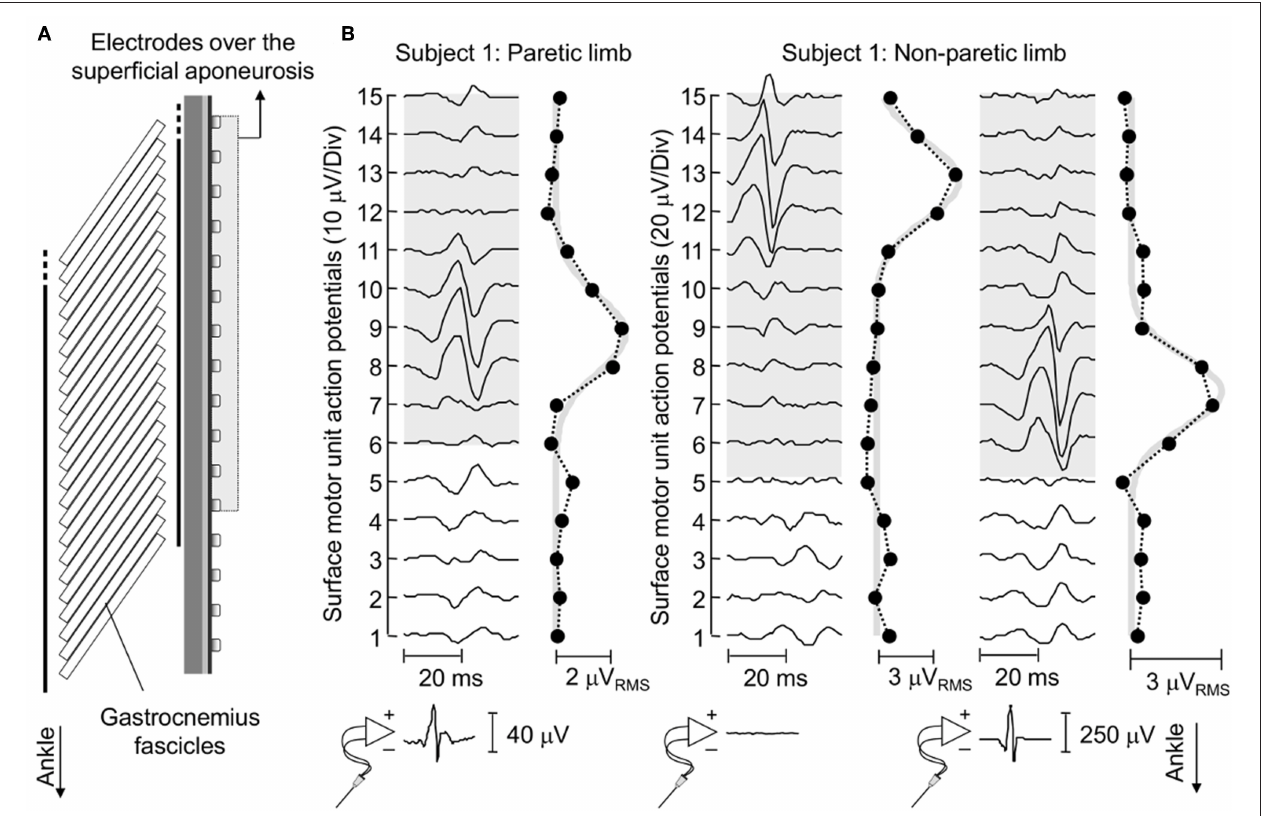
FIGURE 4 | Surface representation of motor unit action potentials. (A) schematically illustrates the relative position between surface electrodes and MG fascicles for a representative subject. (B) shows the spike triggered average potentials of motor units identified for EMGs detected from the paretic and non-paretic MG muscle, both from the skin surface and intramuscularly. The absence of an action potential in the bottom trace of the central panel indicates this motor unit was identified through decomposition of surface EMGs. Circles denote the root mean square (RMS) amplitude of each surface EMG. Note the greatest RMS values appear in correspondence of EMGs conveying the biggest potentials. Thick gray traces correspond to Gaussian curves fitted to the distribution of RMS values (11). These curves were estimated by considering the RMS values of surface EMGs detected by electrodes over the superficial aponeurosis (shaded area).